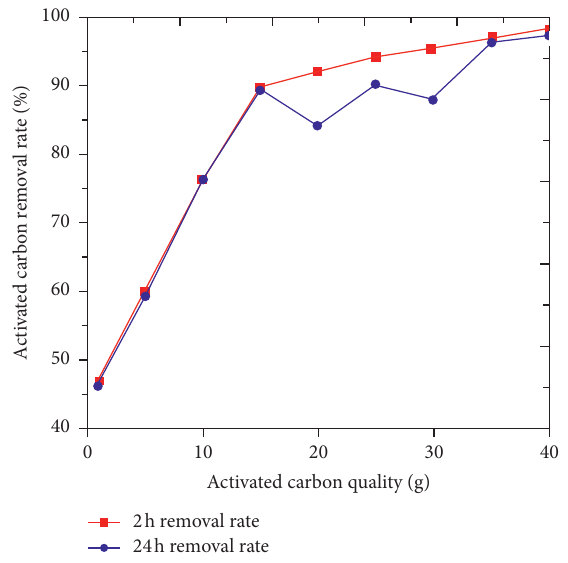
Figure 4: Removal rate of pollutant toxicity of activated carbon with different